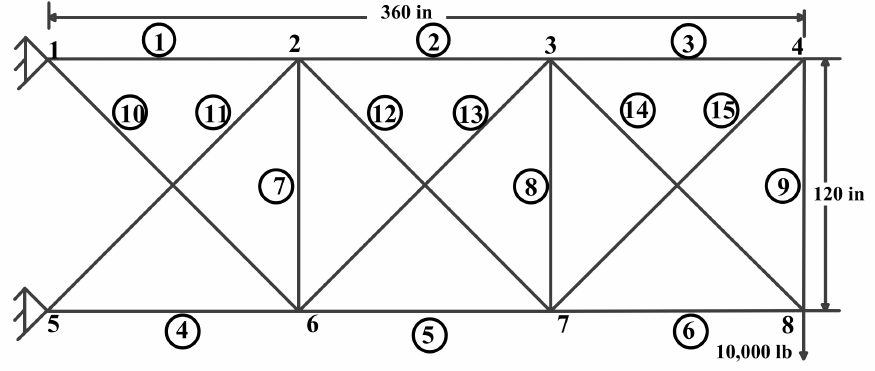
Figure 7. Ground structure of the 15-bar